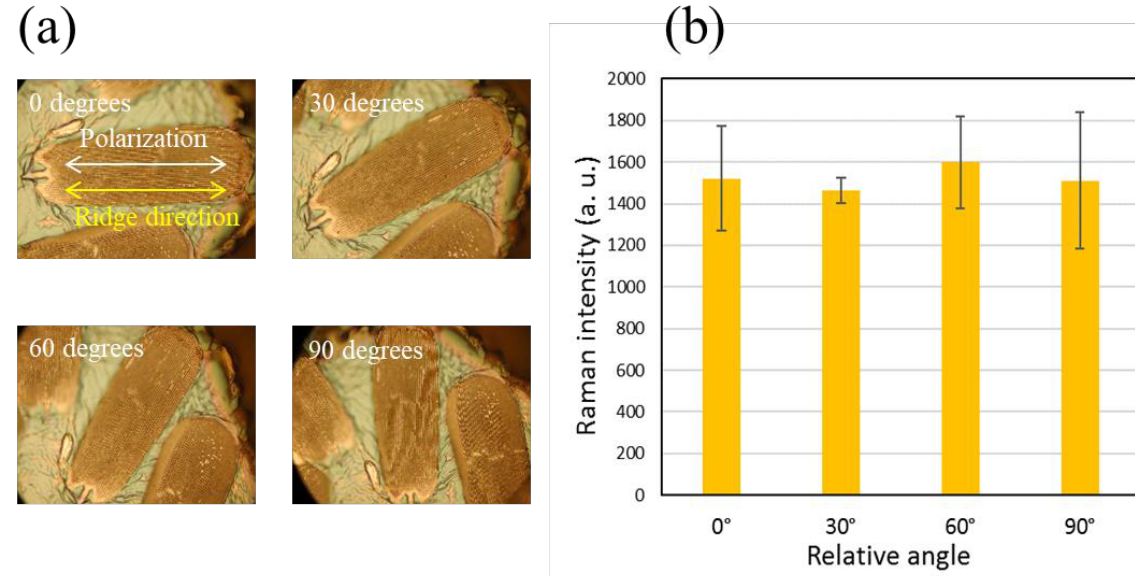
Figure A7. Polarization dependence of SERS spectra of 1 mM R6G. A scale was rotated at an increment of 30 degrees. The angle of zero degrees corresponds to the situation when the directions of polarization and ridge structure coincided. ( a ) Images of the rotated scale. ( b ) A bar graph showing the 774 cm −1 band intensity as a function of the angle.